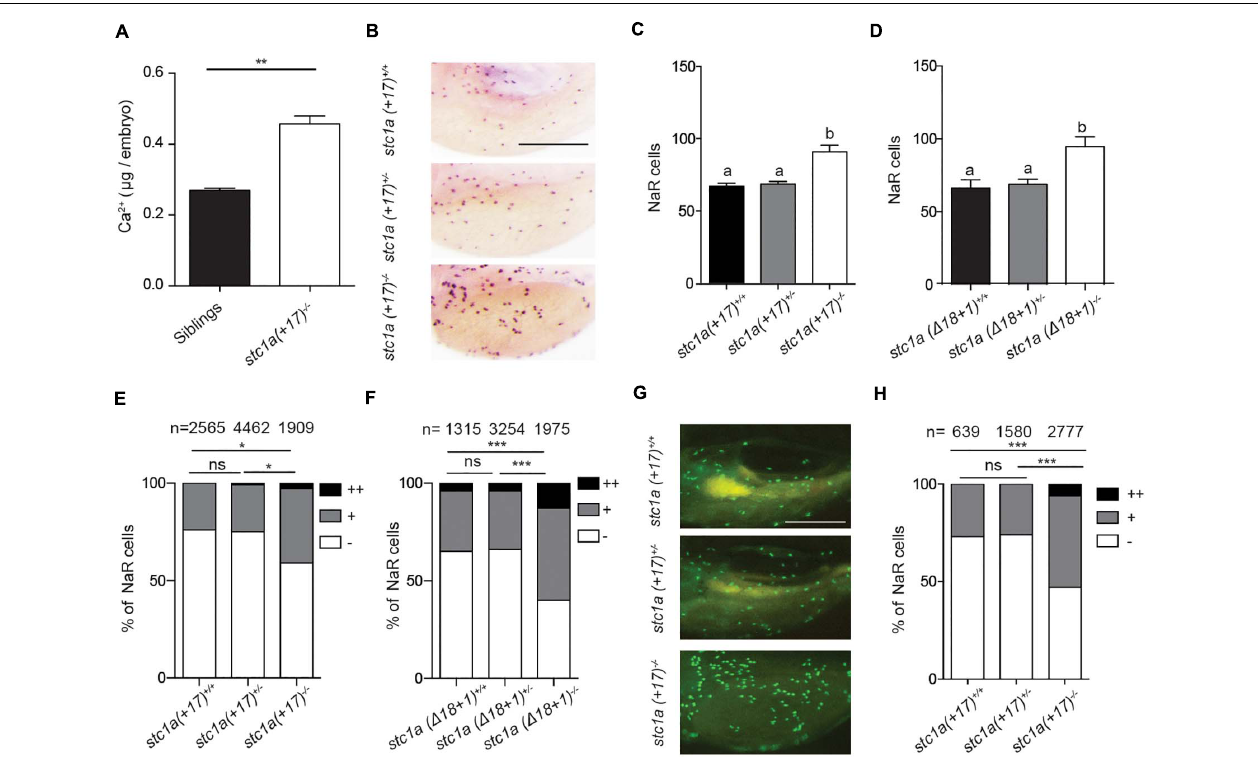
FIGURE 3 | Genetic deletion of stc1a results in elevated body Ca 2 + content and increased NaR cell proliferation. (A) Total body Ca 2 + content in 5 dpf zebrafish larvae of the indicated genotypes. Data shown are from 3 independent experiments, each containing 35 larvae/group. ** P < 0.01 by unpaired two-tailed t -test. (B–D) Progenies of stc1a ( + 17) + / − intercrosses (C) or progenies of stc1a ( (cid:49) 18 + 1) + / − intercrosses (D) were raised in the E3 embryo medium to 5 dpf. NaR cells were detected by in situ hybridization using an igfbp5a cRNA probe. After NaR cells were visualized and quantified in each fish, fish were genotyped individually. Representative images are shown in (B) and quantified data in (C,D) . Scale bar = 0.2 mm. n = 33–70 larvae/group (C) and 19–46 larvae/group (D) . (E,F) NaR cells in 5 dpf larvae of the indicated genotypes were scored following a published proliferation scoring index (Liu et al., 2018). Cells that divided 0, 1, or 2 times were scored as -, +, and ++. * P < 0.05 and *** P < 0.001 by Chi-square test. Total number of cells is shown above the bar. (G,H) Progenies of stc1a ( + 17) + / − ; Tg (igfbp5a: GFP) intercrosses were raised in E3 embryo medium until 5 dpf. GFP-expressing NaR cells were scored as described in (E) . Representative images are shown in (G) and quantified results in (H) . Scale bar = 0.2 mm. *** P < 0.001 by Chi-square